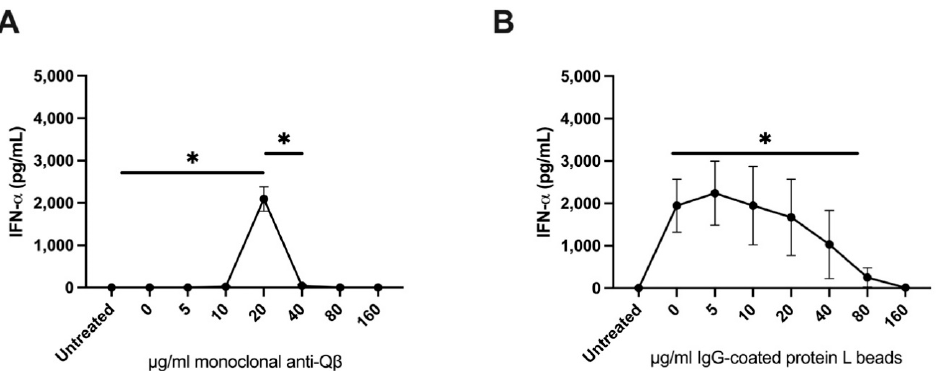
Figure 7. Monocytes exposed to high concentrations of immune complexes inhibit the Type I Interferon response of pDCs to vidutolimod and G10. Purified pDCs were cocultured with monocytes and treated with ( A ) vidutolimod and various concentrations of anti-Q β antibodies or ( B ) G10, a soluble TLR9 agonist and various amounts of IgG-coated protein L beads. Supernatant was tested for IFN α by ELISA. Graph depicts mean +/ − SEM. Statistical significance was determined using multiple paired T test with alpha = 0.05 ( n = 3–4; * p < 0.05). Statistically significant decreases in IFN α occurred beginning at 40 μ g/mL of anti-Q β (panel A) and at 80 μ g/mL of IgG-coated protein L beads (panel B). Type 1 Interferon production by pDCs plus monocytes occurred in response to a nar- rower window of doses when treated with anti-Q β -coated vidutolimod compared to IgG- coated protein L beads plus G10. There are a number of possible explanations for this. Figure 7A involved addition of soluble anti-Q β to a sample containing a set amount of vidutolimod allowing for development of immune complex in the sample while Figure 7B involved addition of varying amounts of immune complex itself. We previously re- ported that uptake of antibody-coated vidutolimod by monocytes is significantly higher than that of pDCs even though pDC uptake is responsible for the resulting production of Type I Interferon [3]. There is likely competition for uptake of vidutolimod in the experi- ments illustrated in Figure 7A between monocytes and pDCs that impacts on TLR9 ago- nist activation of pDCs. While the shapes of the curves are different, the conclusion from both experiments is that monocytes treated with immune complexes suppress the ability of TLR9 to induce Type I Interferon production by pDCs. 4. Discussion Anti-Q β antibody levels vary considerably over the course of therapy in patients who are treated with repeated doses of vidutolimod. At the start of therapy, anti-Q β Ig levels are negligible. The Q β capsid is highly immunogenic, and anti-Q β , first IgM and then IgG, develops rapidly. The anti-Q β IgG continues to increase with subsequent doses of vidu- tolimod. Thus, the formation of immune complexes based on binding of anti-Q β antibody to vidutolimod changes throughout the course of therapy from there being no such com- plexes prior to therapy, to there being partial saturation of vidutolimod by anti-Q β anti- body early in the course of therapy, to finally, vidutolimod being highly saturated by anti- Q β antibody later in the course of therapy. There are 180 Q β subunits per vidutolimod. The molecular weight of vidutolimod and anti-Q β IgG is 14,254 and 150 kDa, respectively. Given the concentrations used in the experiments reviewed here, 20 micrograms per mL of anti-Q β (in a total volume of 200 μ L), where induction of Type I Interferon is first seen, would equate to 190 IgGs per vidu- tolimod molecule. The production of Type I Interferon is largely lost at 80 micrograms per mL of anti-Q β (in a total volume of 200 μ L), which would equate to 760 IgGs per viduto- limod molecule. Thus, partial saturation of vidutolimod by anti-Q β induces high levels of Type I Interferon, while more complete saturation of vidutolimod by anti-Q β results in limited Type I Interferon. Based on the clinical data on anti-Q β generation presented in